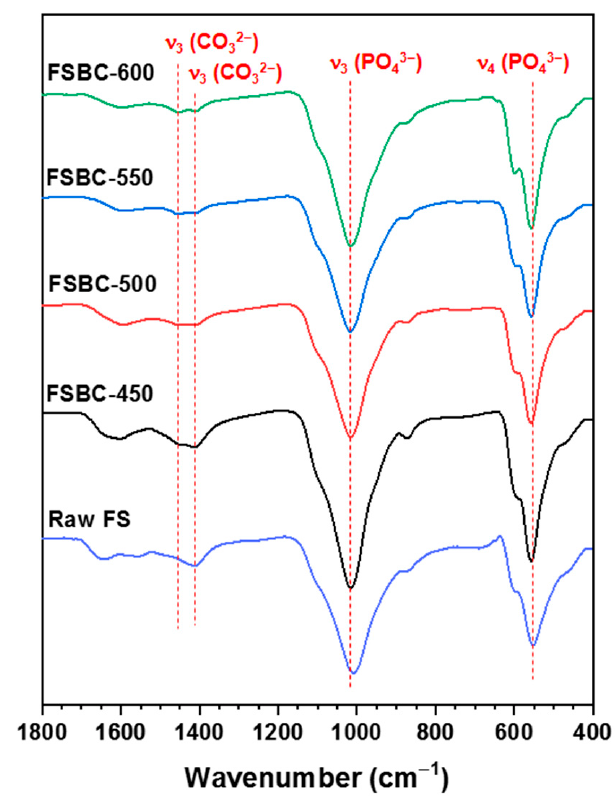
Figure 6. FTIR spectra of the FSBC products that were derived from different pyrolysis temperatures. Based on the experimental results and discussion, the dissolution process of FSBC carbon/HAP nanocomposites required the interaction between HAP on the solid particles and citrate species in the solution. Therefore, the dissolution performance of these materials depends on their specific surface area and the presence of carbon component. However, the degree of carbonation and crystallinity is also involved in controlling their